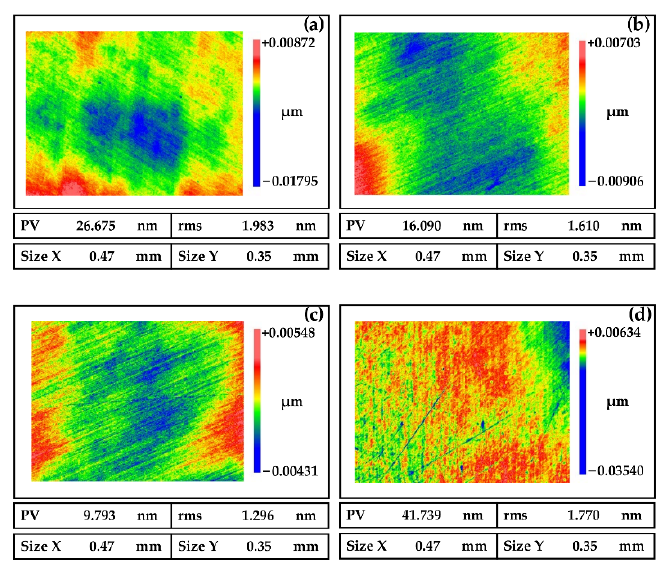
Figure 8. Polished surfaces of NiP coating induced by different pressures ( a ) 0 MPa, ( b ) 0.01 MPa, ( c ) 0.02 MPa, and ( d ) 0.03